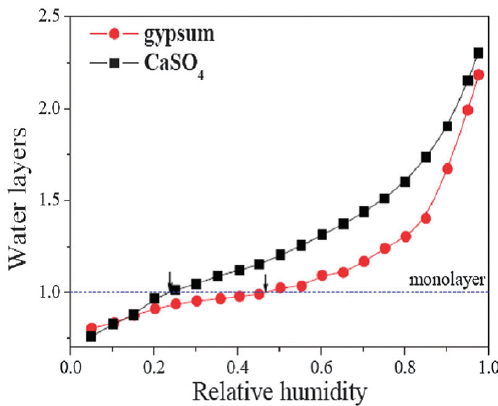
Figure 2. Water adsorption isotherms of CaSO 4 (black square) and gypsum (CaSO 4 · 2H 2 O, red circle) at 278K. Reprinted with permis- sion by Q. Ma et al. (2013). Copyright 2013 PCCP Owner